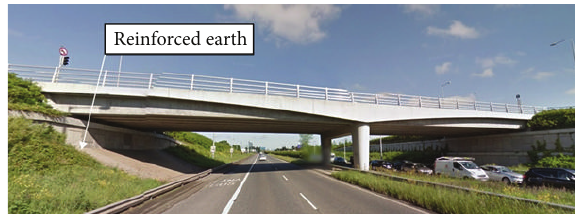
Figure 3: Two-span integral bridge with flexible abutment